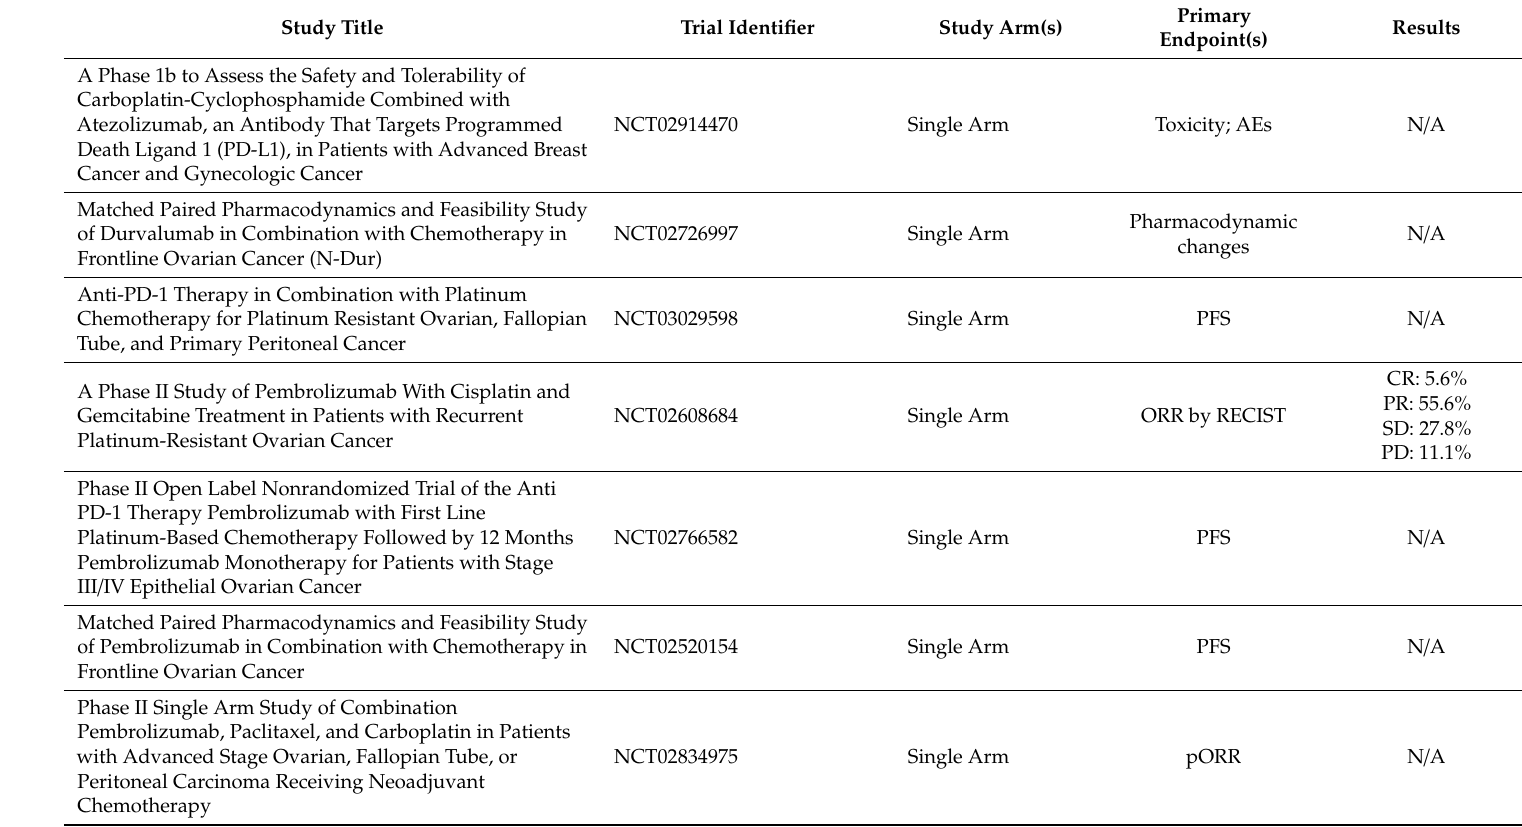
Table 1. PD-1 and